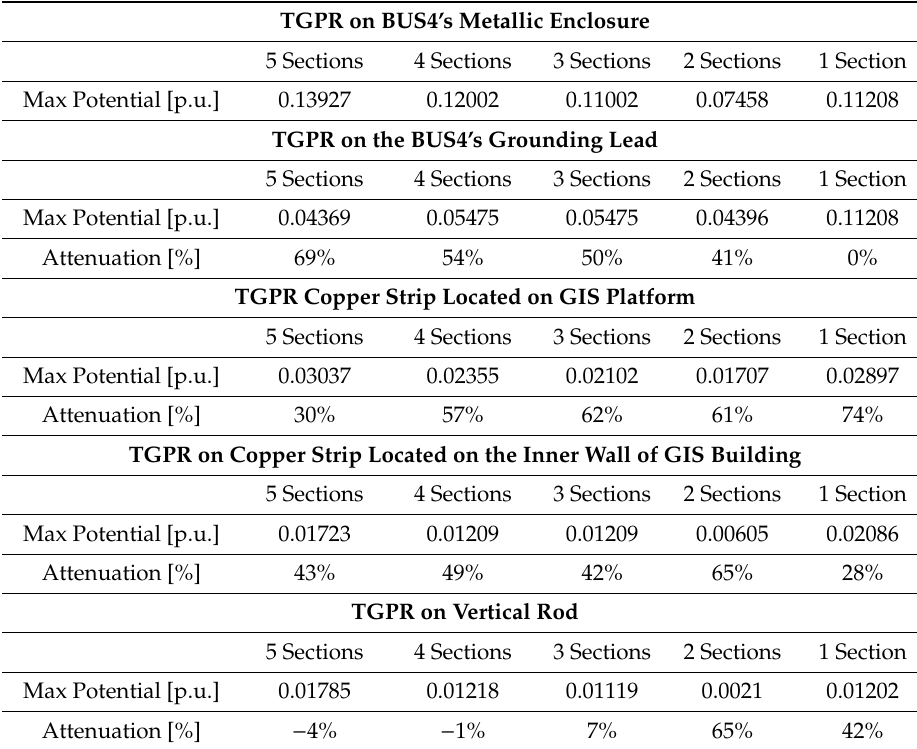
Table 2. Maximum absolute amplitudes describing the TGPR waveforms at di ff erent locations. TGPR on BUS4’s Metallic